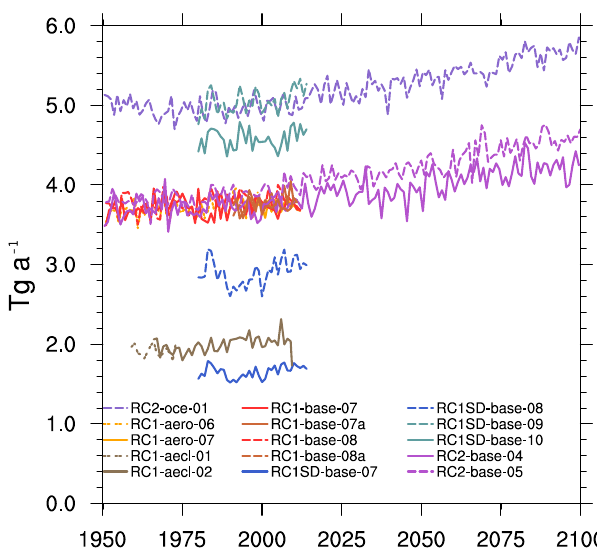
Figure 4. Annual total emissions of lightning NO x in Tg ( N ) a − 1 . Figure 5. Simulated annual total emissions of DMS (in Tg ( S ) a